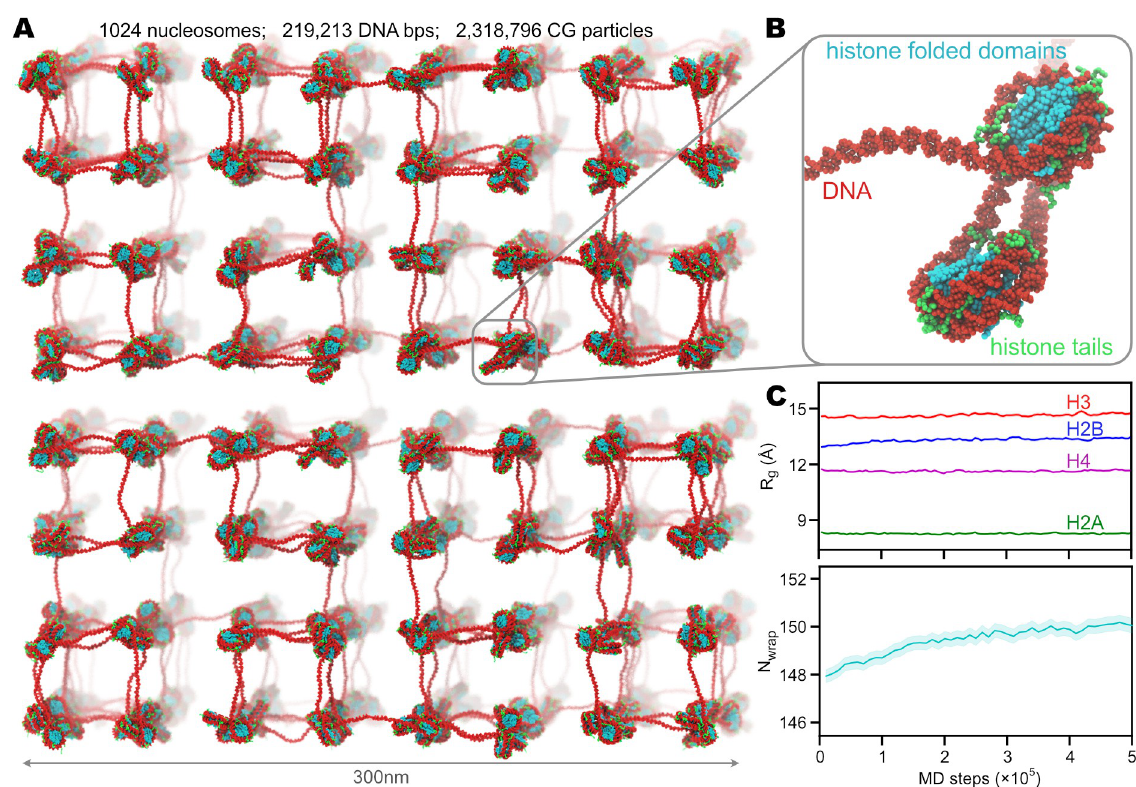
Fig 8. MD simulation of artificial chromatin composed of 1024 nucleosomes. (A) Structure of the whole artificial chromatin. DNA is colored in red, and histones are colored in cyan (for the folded domains) and green (tails). (B) A zoom-in structure of two adjacent nucleosomes as a part of the artificial chromatin. (C) Time series of the radius-of-gyration ( Rg ) of the N-terminal tails of the histones (top) and the number of wrapped DNA base-pairs on histone (bottom). The solid lines represent the average values, and the shadowed regions show the standard